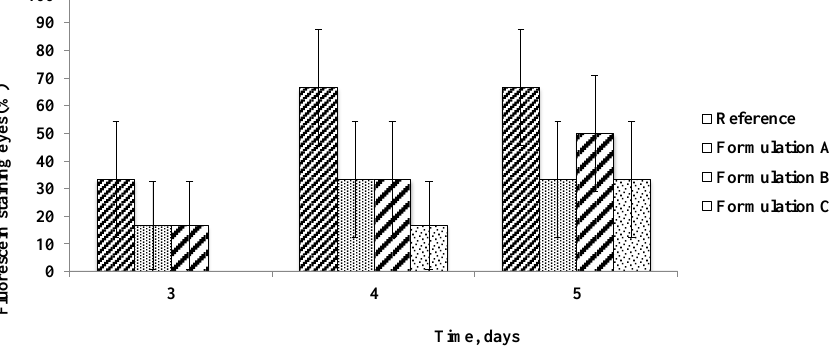
Figure 7. Percentage of fluorescein staining eyes during time in response to AS solution treatment in the contralateral eyes (Reference) and in the eyes treated with the Formulations under study after instillation of AS solution (Means ± SE, n = 6).